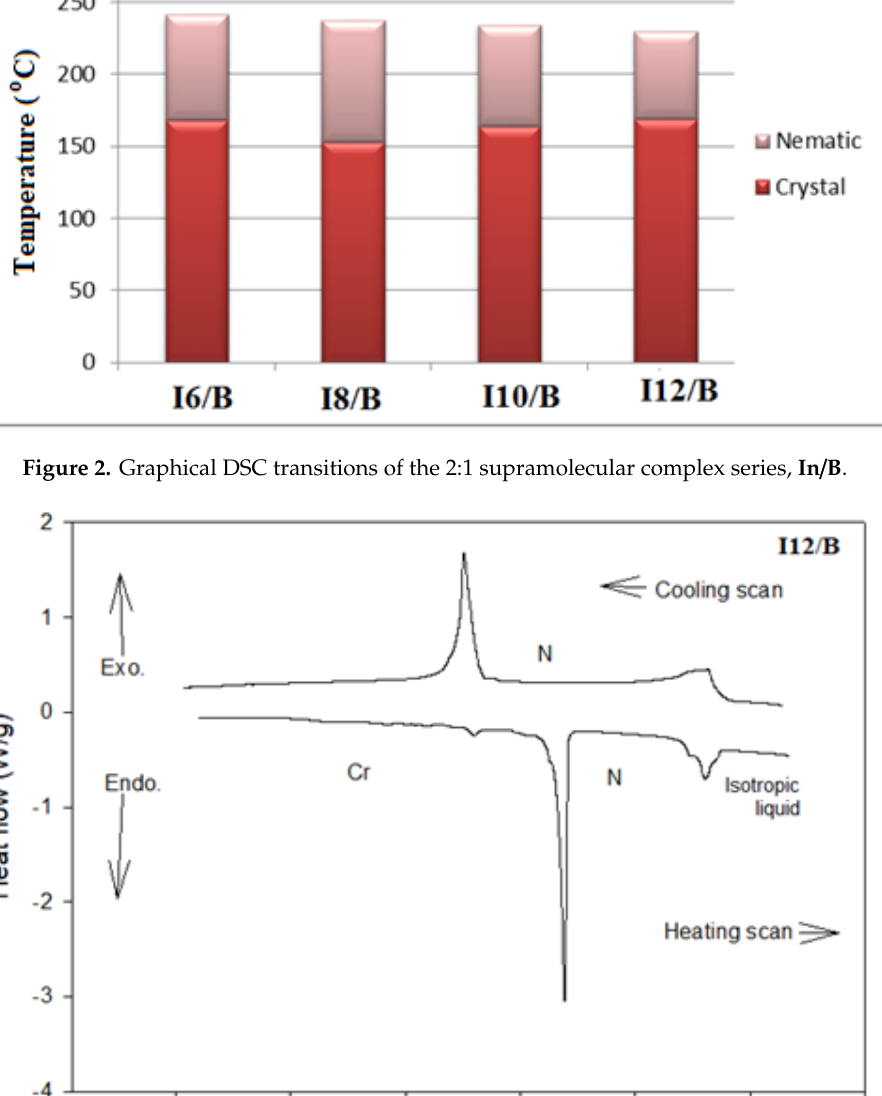
Figure 4. Nematic polarizing optical microscopy (POM) textures on heating for 2:1 supramolecular complexes ( a ) I12/B at 218.0 °C, ( b ) I12/B at 225.0 °C ( c ) and I8/B at 180.0 °C phases. The normalized entropy, driven form DSC, of transitions ( ∆S/R ) were calculated for the present supramolecular In/B complexes and the results are tabulated in Table 1. The results indicate an increment of the entropy change with the terminal alkoxy chain length (Figure 5) that reflects the